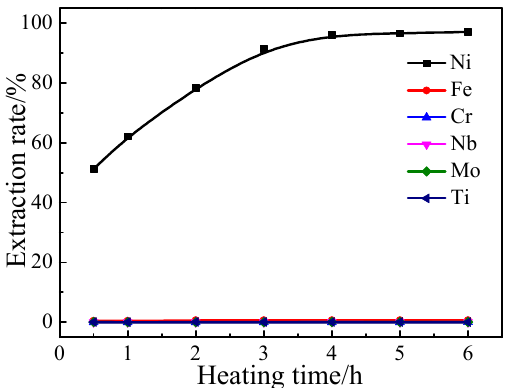
Figure 12. Effect of heating time on the extraction of metals (Note: the curves for Fe, Cr, Nb, Mo and Ti are overlapping).